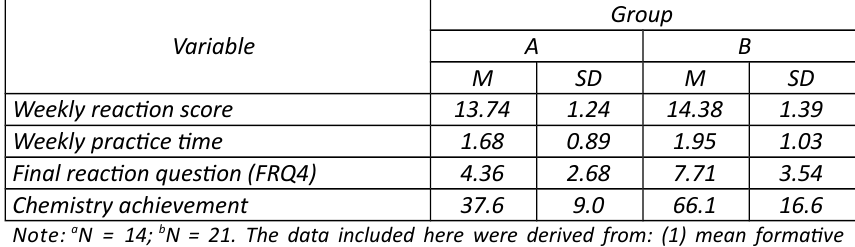
Table 1.Performance data for group A and group